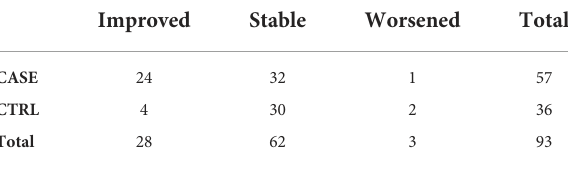
TABLE 5 MTS variation 1 month after surgery in CASEs and